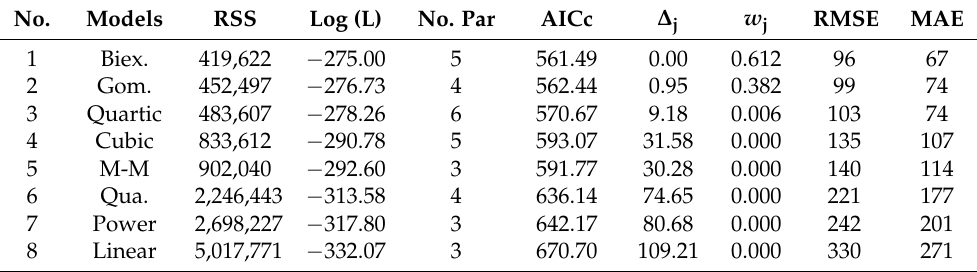
Table 2. Summary of model selection